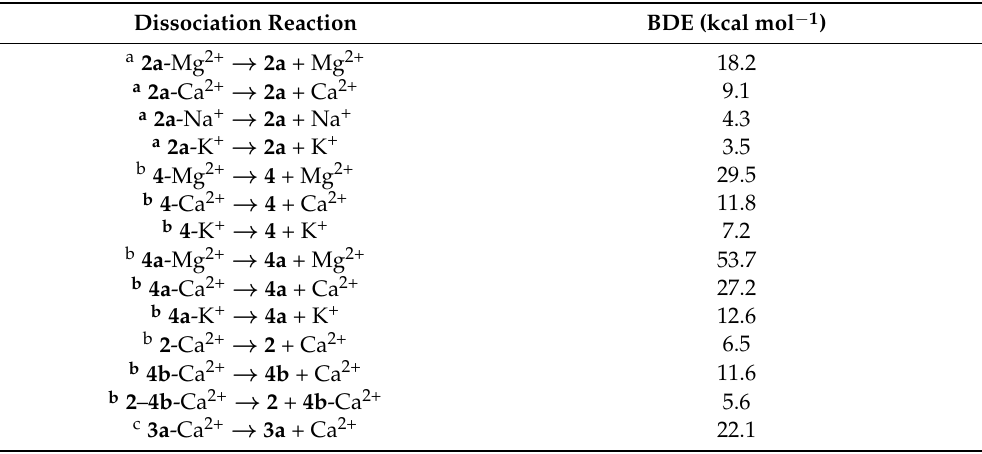
Table 2. Bond dissociation energies of complexes in